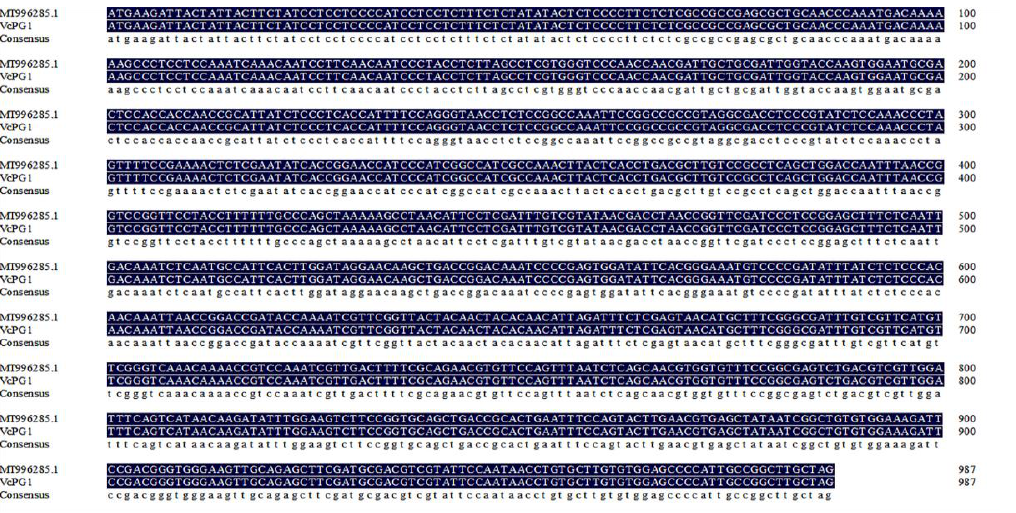
Figure 7. Sequencing result of VcPG1 full − length coding region. Compared with the mRNA of Vaccinium corymbosum polygalacturonase mRNA (MT996285.1) in NCBI, the similarity was 100%.